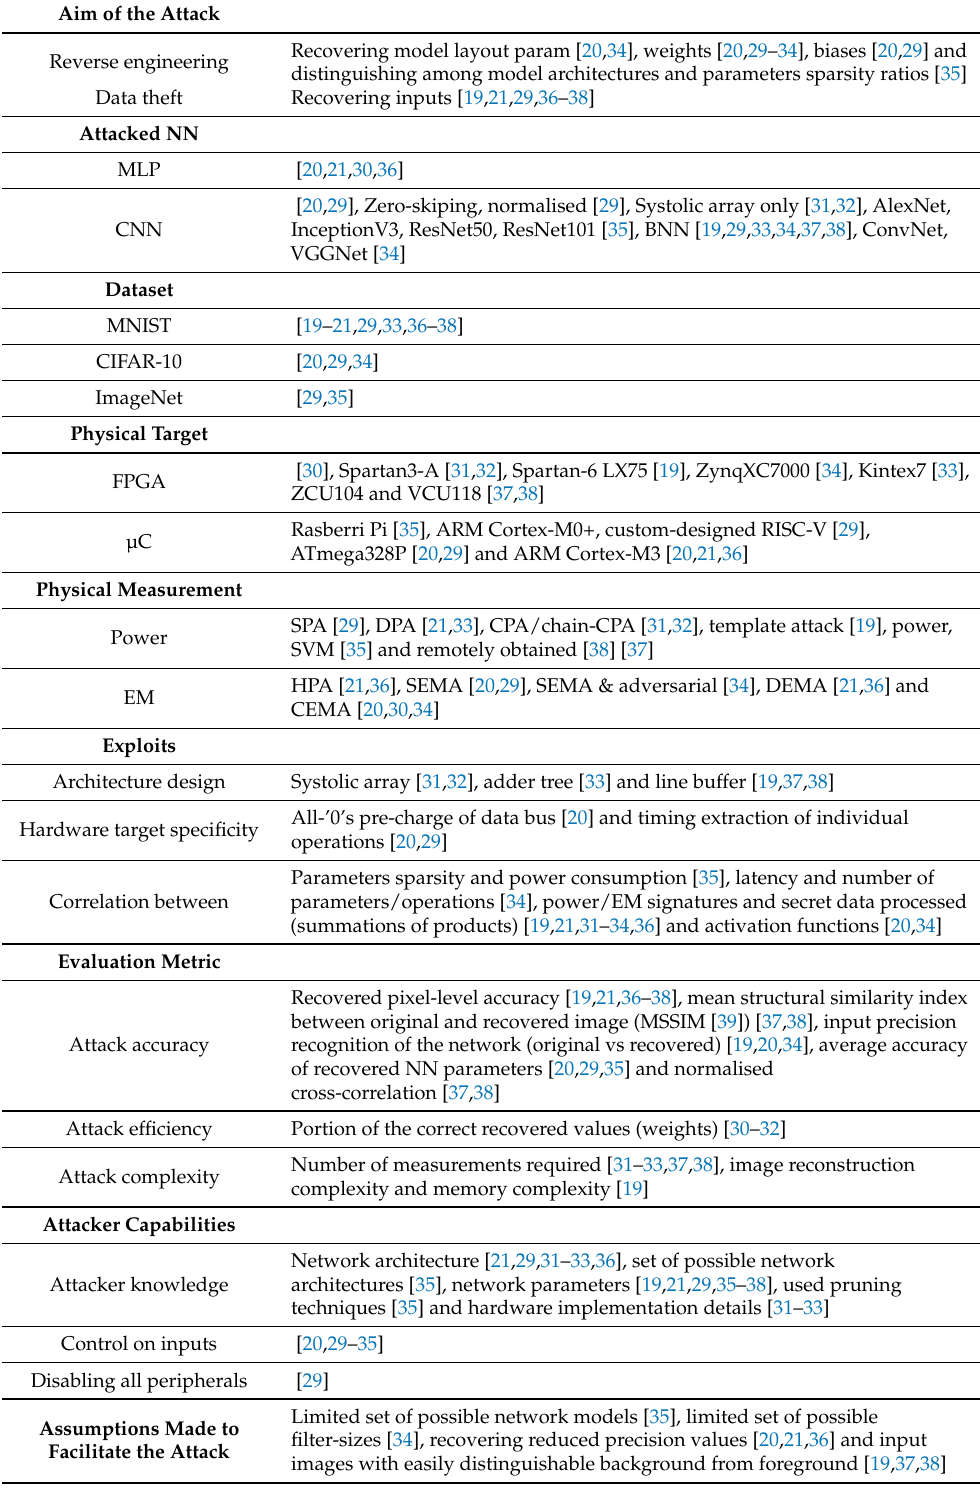
Table 2. Classification of attacks according to each